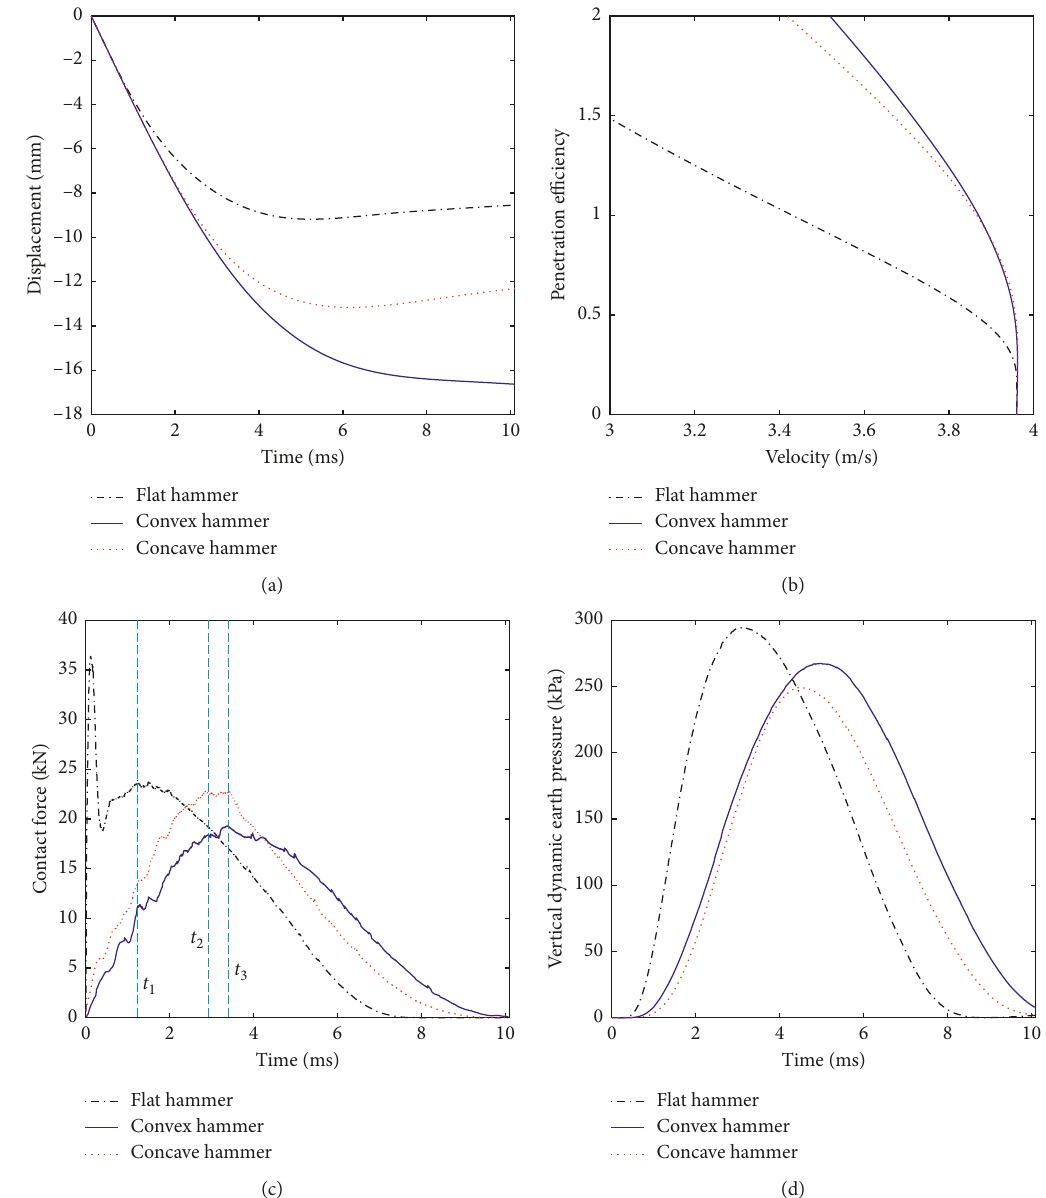
Figure 6: Time history of (a) displacement and (b) penetration efficiency, (c) contact force between hammer and soil, and (d) vertical dynamic earth pressure underneath the hammer for flat, convex, and concave